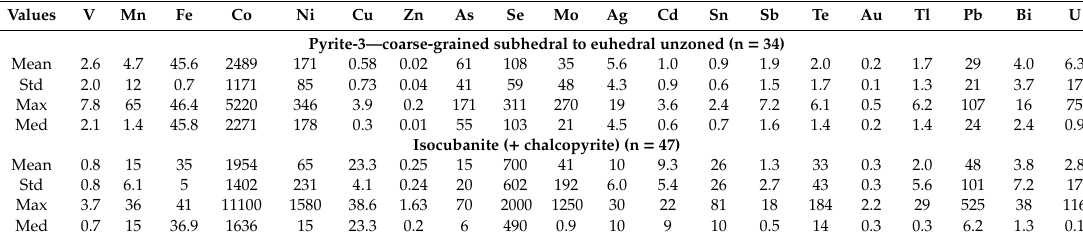
Table 1. Trace element contents in the pyrite-chalcopyrite crusts. Pobeda vent site. LA-ICP-MS data in ppm. Fe, Cu, Zn are in wt. %.